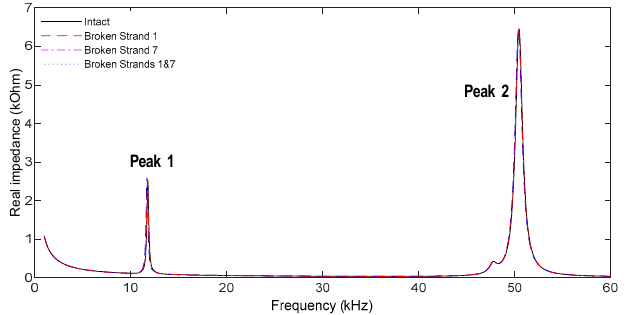
Figure 11. Impedance response of PZT 1 interface under strand breakage events.